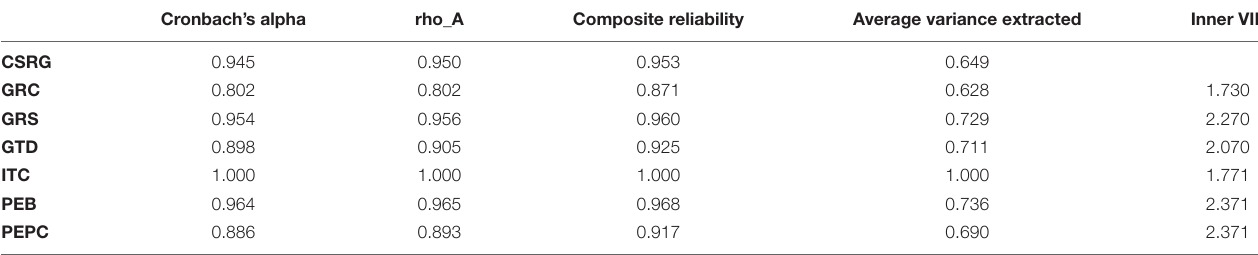
TABLE 3 | Goodness of fit and average variance extracted